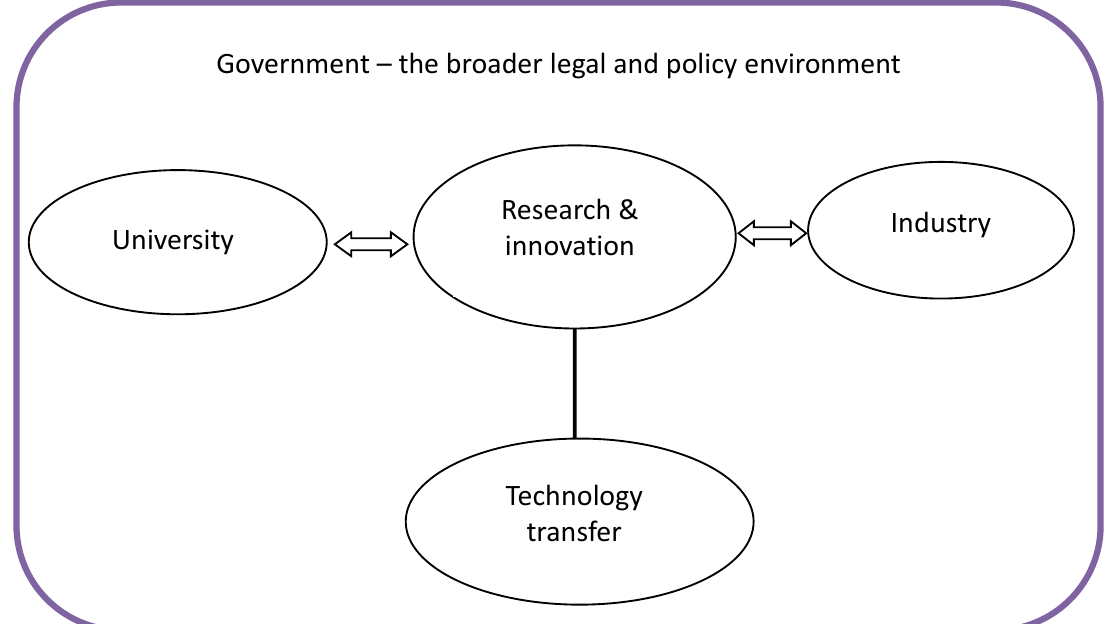
Figure 1. Conceptual framework: Links between academic research & economic